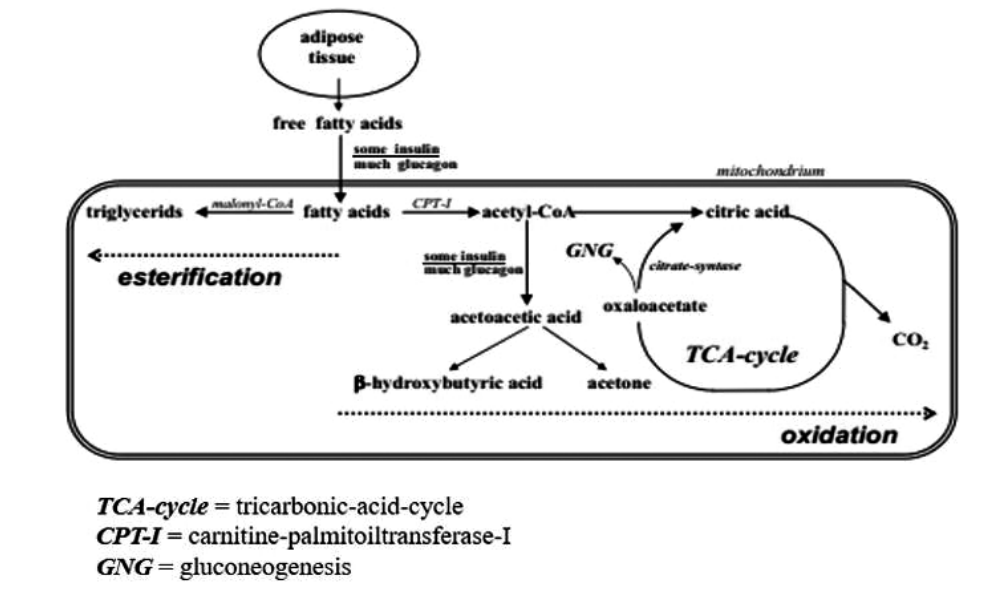
Figure 1: Connection, formation, and transformation of ketone bodies related to TCA-cycle [2].